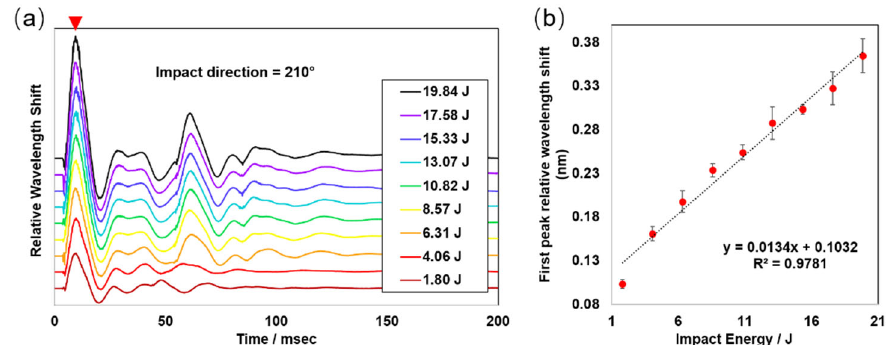
Figure 2. The exemplary transient oscillatory signal generated at an impact direction of 210° and the linear correlation between the impact energy and the FBG wavelength shift. ( a ) Display of transient oscillatory signals generated at an impact direction of 210° under nine different impact kinetic energy levels ranging from 1.80 J to 19.84 J. ( b ) Linear correlation between the relative wavelength shift of the first peak (red arrow) and the applied impact energy. Data points shown in the plot are averaged values ± standard deviations. All experiments were repeated three separate times under the same condition (n = 3).